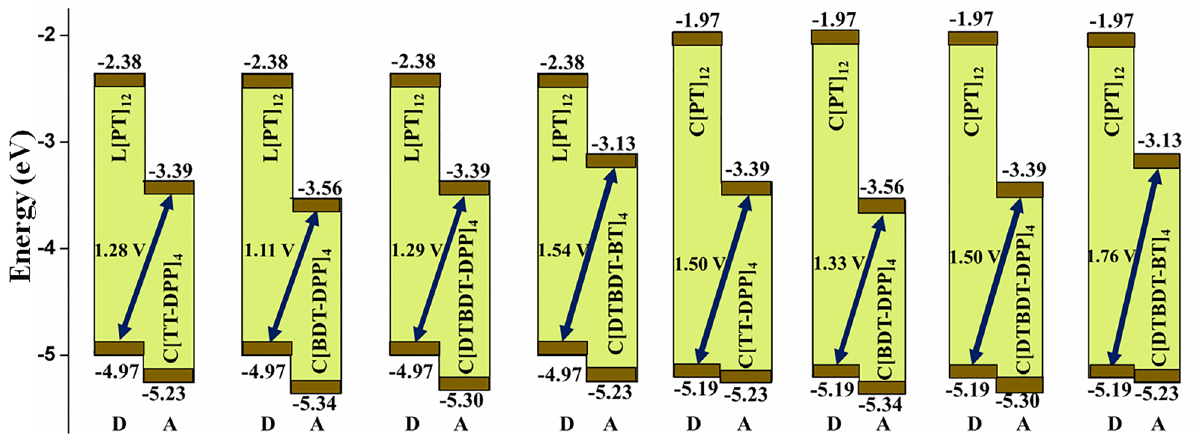
Figure 5. Open circuit voltage (V oc ) of larger macrocyclic compounds with L[PT] 12 and C[PT] 12 as donor